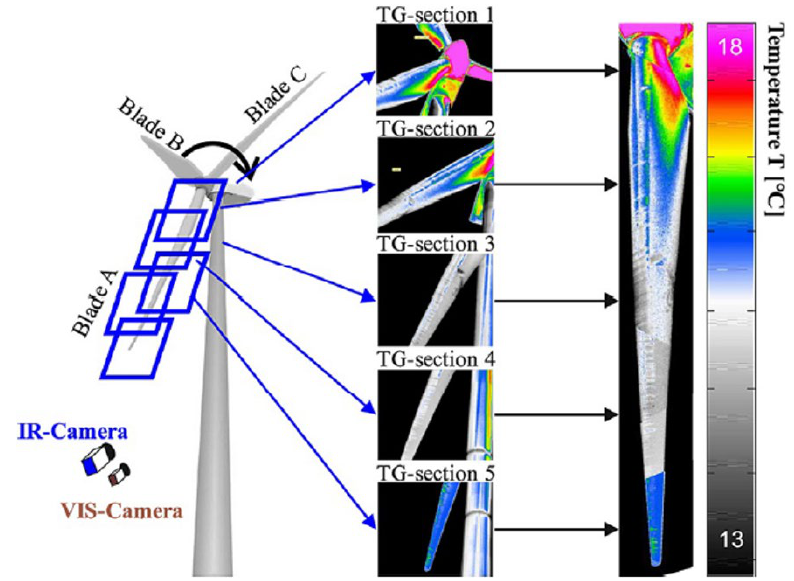
Figure 12. Thermography inspection